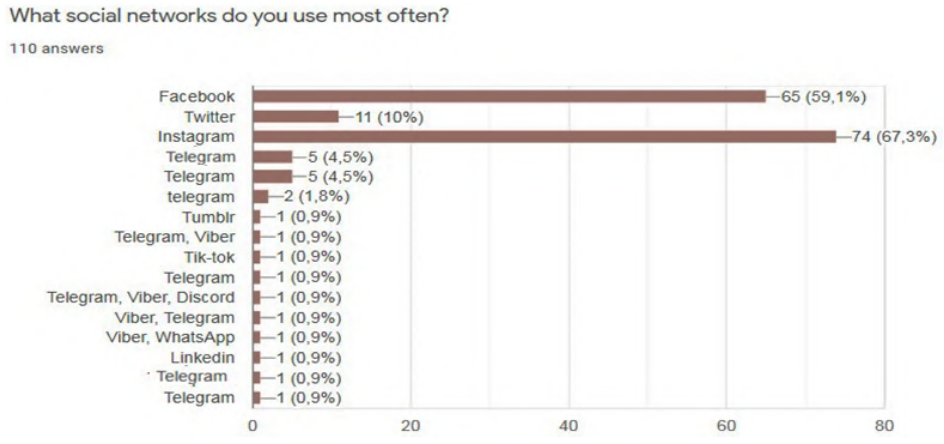
Figure 99: Presentation of paper